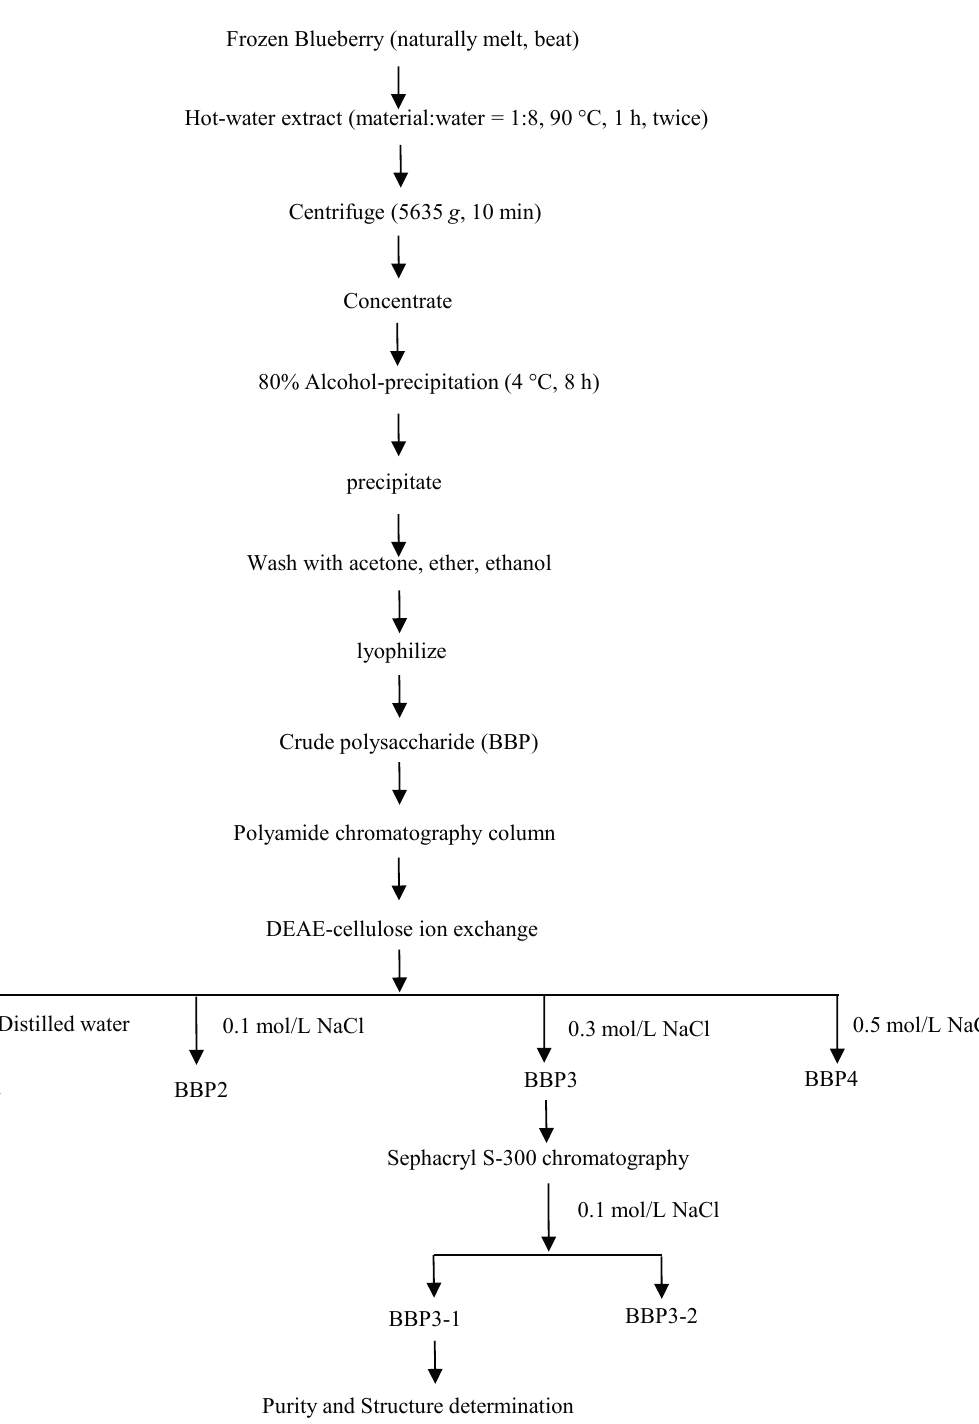
Figure 1. The extract flow diagram of